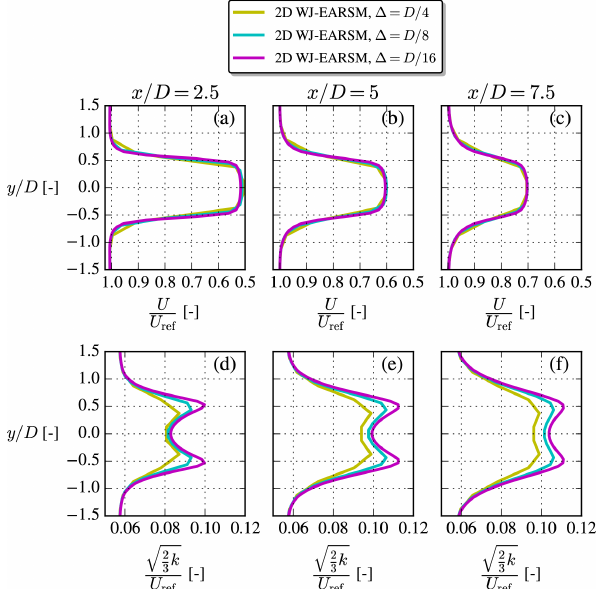
Figure A1. Grid study of streamwise velocity (upper row) and TI (lower row) profiles at hub height for the V80 case with the 2D WJ-EARSM using different mesh